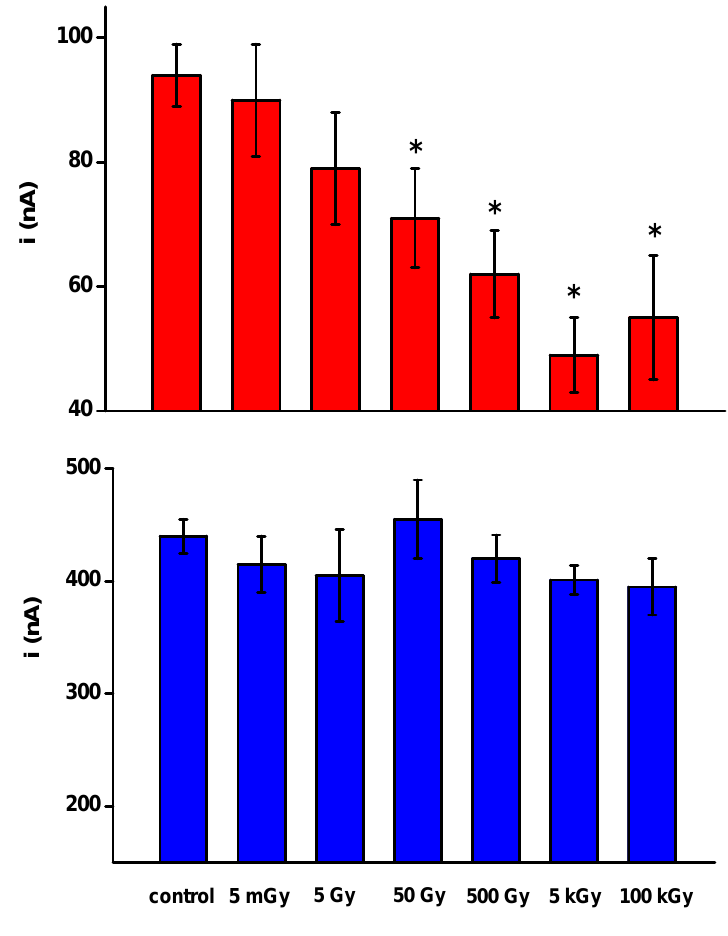
paraoxon 1 ppm. Error bars indicate standard deviation (n = 5). Asterisks indicate significant difference against control at probability level P = 0.05 (ANOVA with Scheffe